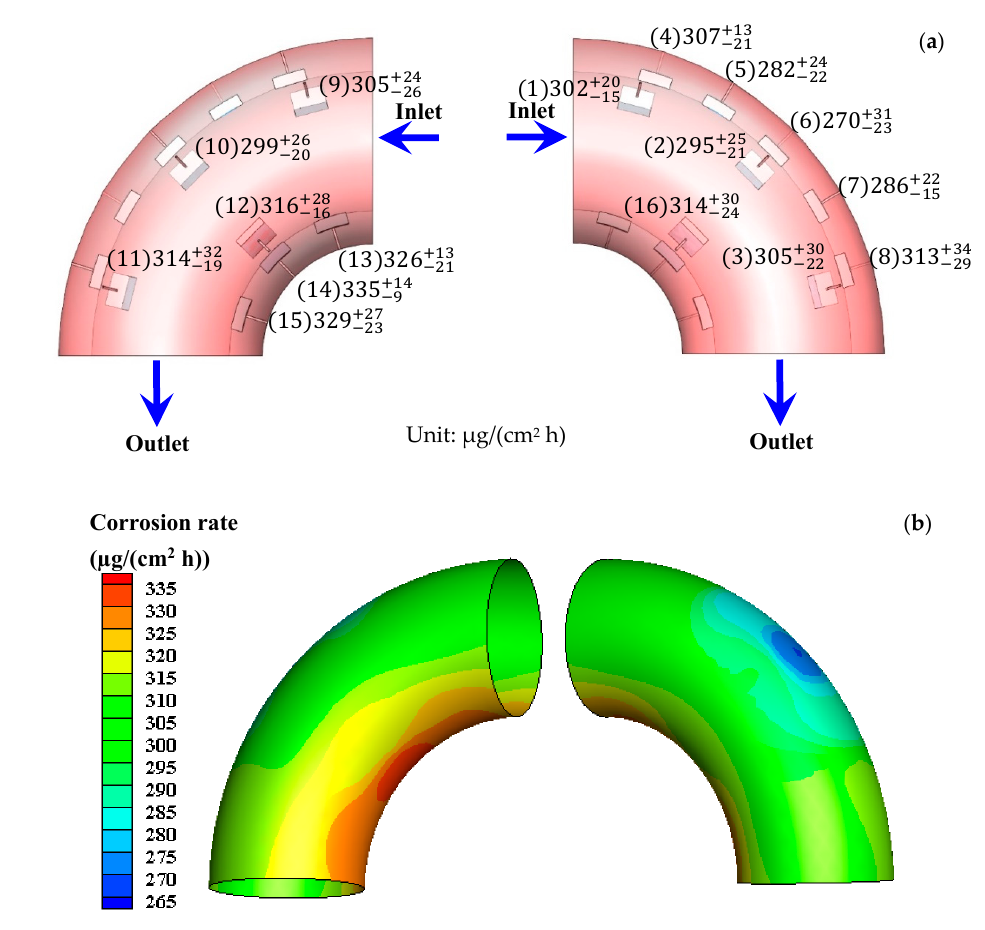
Figure 3. ( a ) Distribution of corrosion rate after the flow-accelerated corrosion (FAC) test and ( b ) contours of corrosion rate after FAC